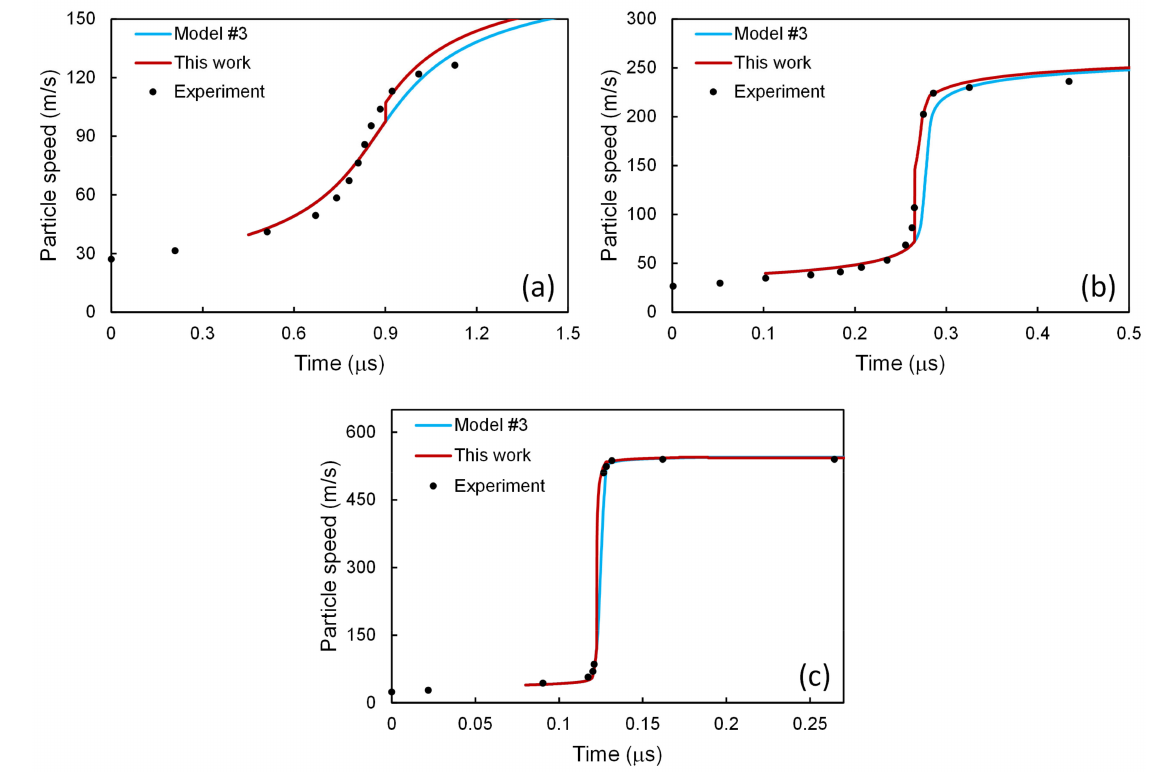
Figure 7. Particle speed profiles for 6061-T6 Al alloy at shock stress amplitudes of ( a ) 2.1, ( b ) 3.7, and ( c ) 9.0 GPa. The present scheme has been applied to model #3 [2,4], and the results are compared with those from model #3 [2,4] and the experimental ones